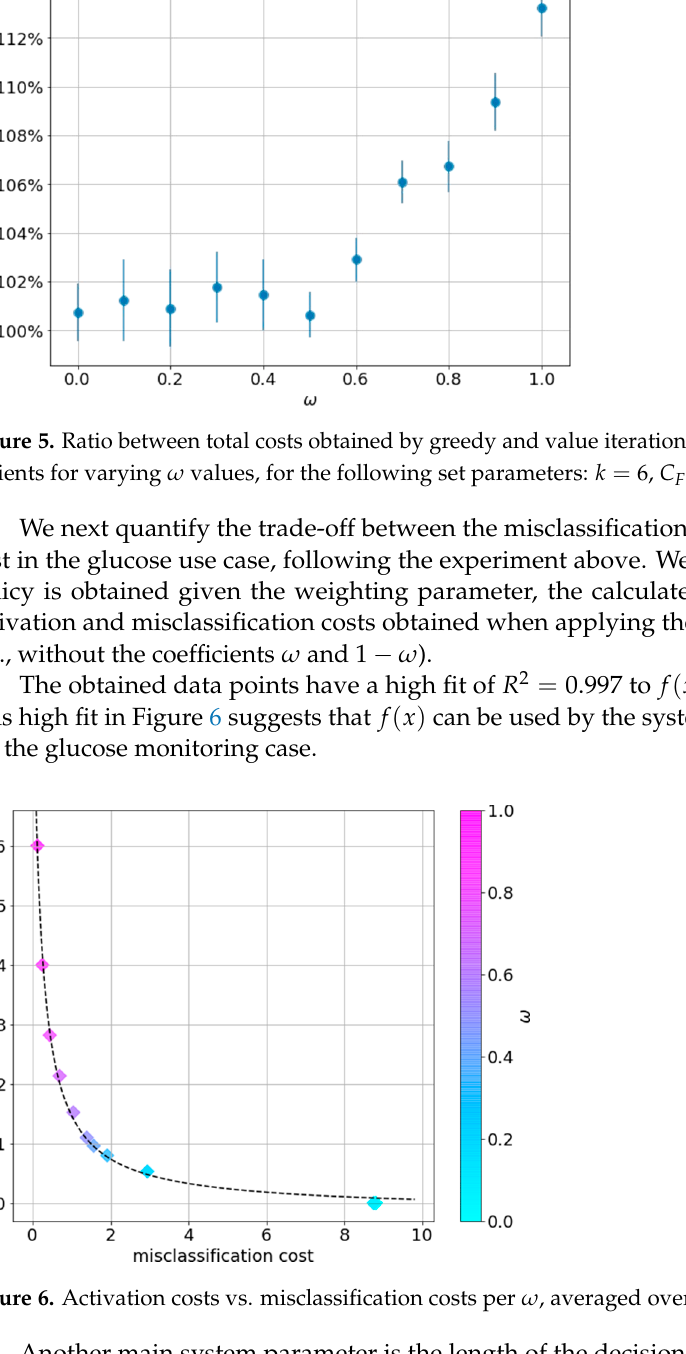
Figure 7. Ratio between total costs obtained by greedy and value iteration methods obtained over all patients for 𝑘 𝑣𝑎𝑙𝑢𝑒𝑠 , for the following set parameters: 𝜔 = 0.5 , 𝐶 (cid:3007)(cid:3015) = 100 , 𝐶 (cid:3007)(cid:3017) = 50 . 6. Empirical Analysis and Sensitivity Analysis on Synthetic Data In this section, we provide simple numerical examples that will allow us to study the behavior of the greedy policy compared to the optimal policy in more detail, and to pro- vide more intuition and interpretability for the proposed greedy policy. For the glucose data, the transition matrix and sensor accuracies were estimated for the data so they do not represent a degree of freedom. Here, all parameters are arbitrary, allowing for a more general sensitivity analysis. 6.1. WBAN Dynamics for the Greedy Policy We define the model parameters as follows: 𝐽 = 4 (the number of health states), 𝑁 = 5 (the number of sensors). Additional parameters are as follows: